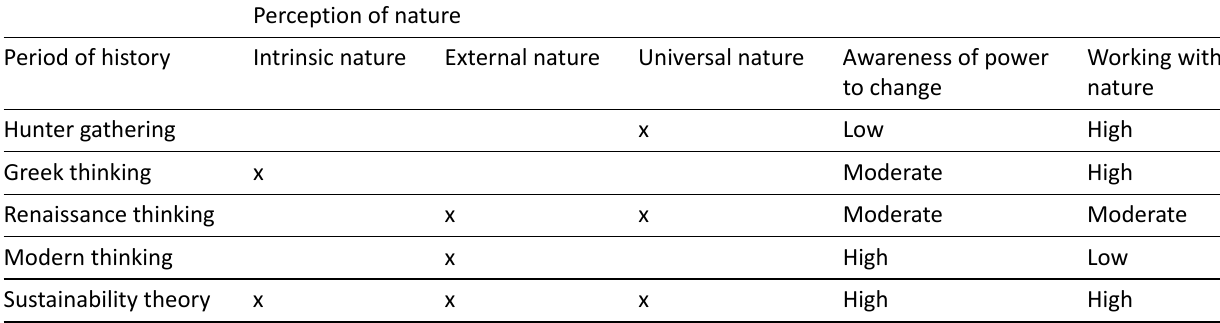
Table 1. Different views of nature. Source: authors.